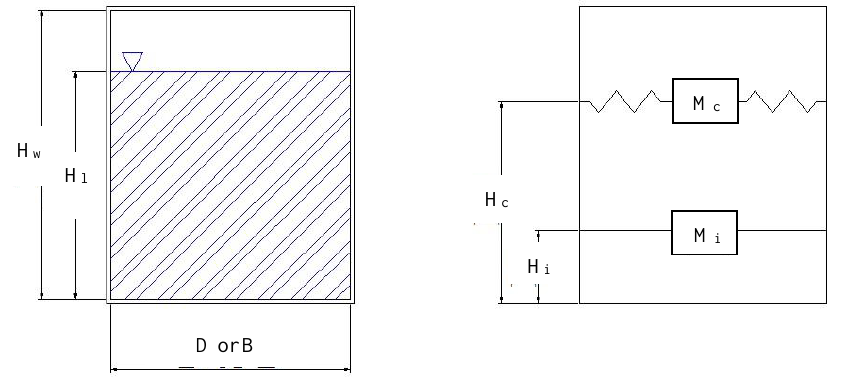
Figure 1. Schematic view of Housner’s simplified model.